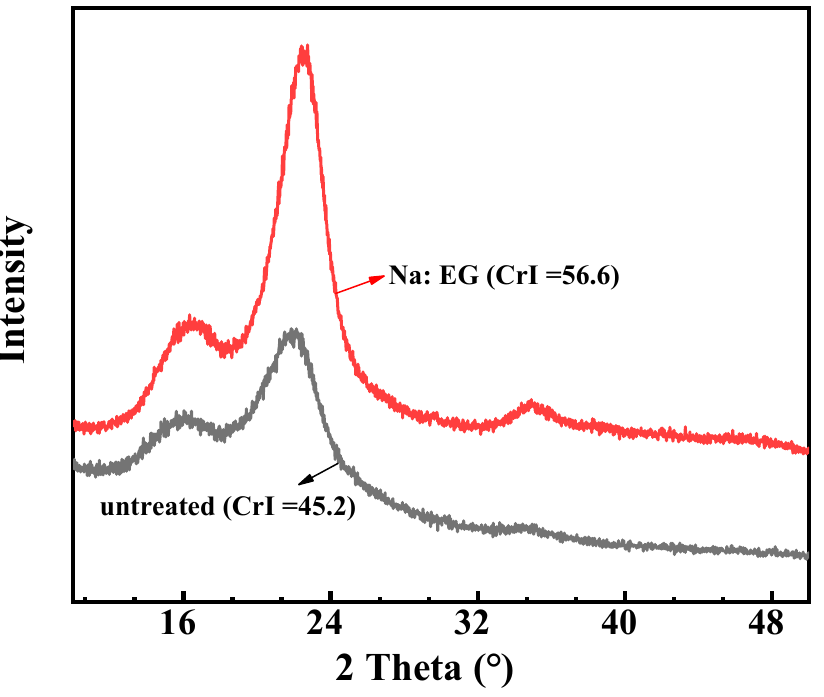
Figure 10. XRD pa tt ern of untreated wheat straw and Na:EG-treated residue. Figure 10. XRD pattern of untreated wheat straw and Na:EG-treated